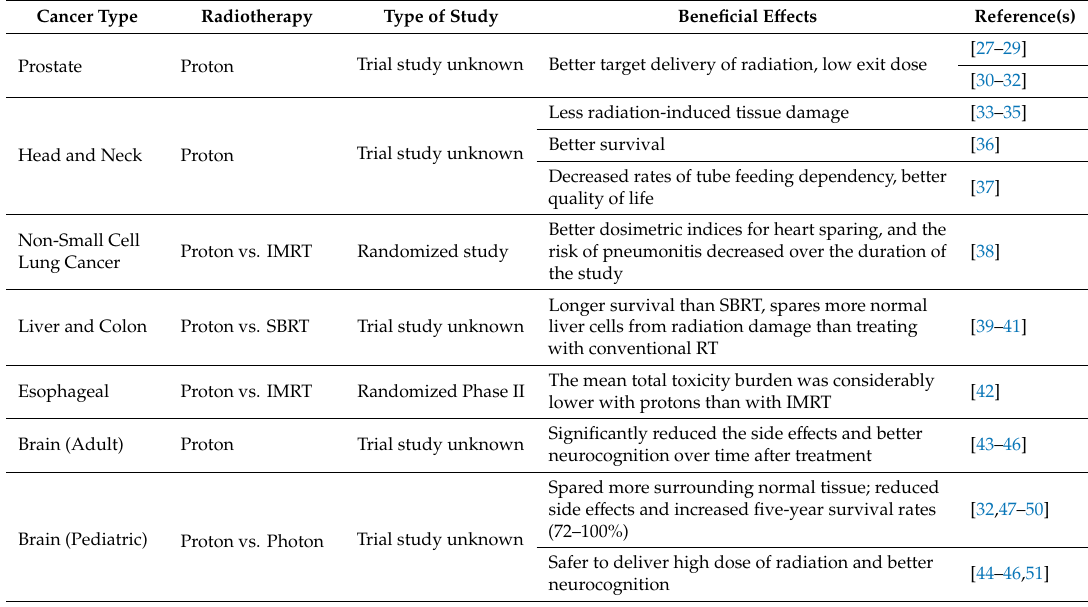
Table 1. Advantages of Proton